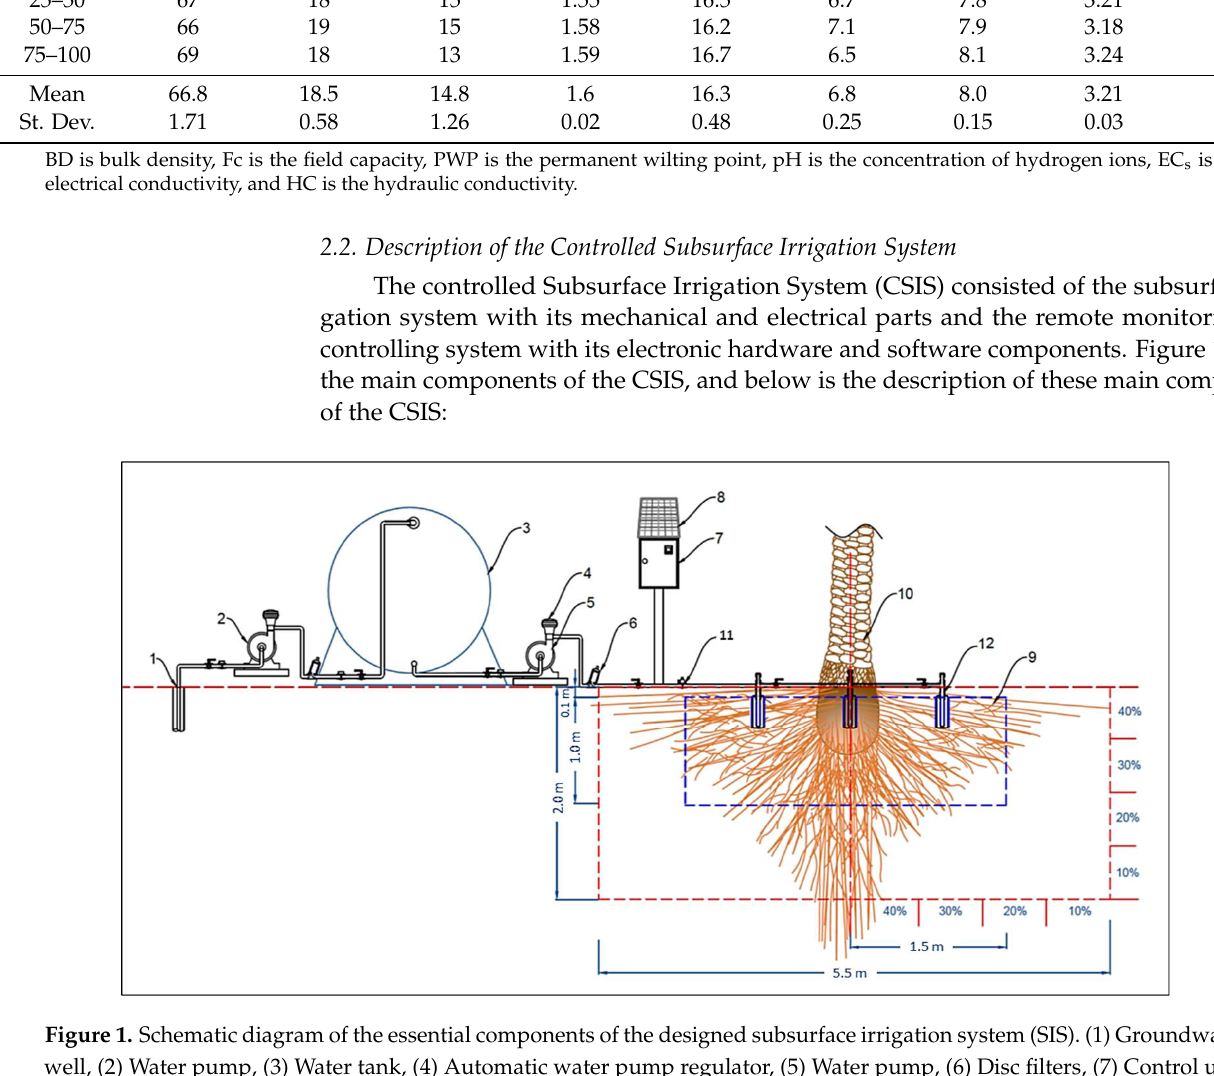
Figure 2. Schematic diagram of the designed subsurface irrigation unit used in the controlled sub- surface irrigation system (dimensions in m). (1) Water source, (2) Manual valve, (3) Water flow regulator, (4) Perforated inner pipe, (5) Filtering cloth of the inner pipe, (6) light volcanic gravel, (7) Slotted outer pipe, (8) Filtering cloth of the outer pipe, (9) Twistable dripper head, (10) Water droplet, (11) Ground level. The length of the outer pipe was 0.30 m with a diameter of 0.10 m and slotted with a tilt angle of 30°. The slot width and length were 0.002 m and 0.004 m. The length of the